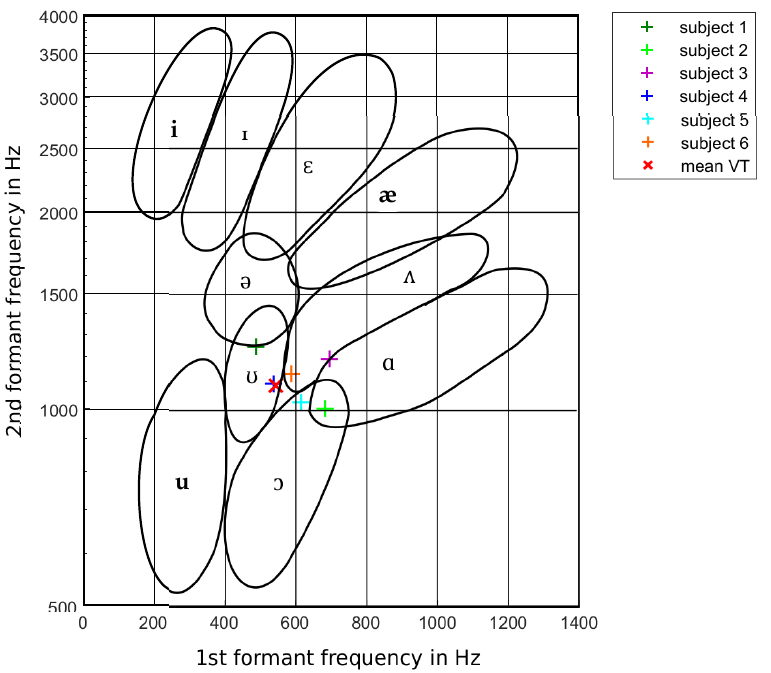
Figure 10. The formant chart as proposed by Peterson and Barney [56], shows the formant frequencies for the mean VT, which is based on the MRI-data of six professional tenors. In addition, formant frequencies of the individual tenors are shown, as detected by Echternach et al. [34] in the audio recordings.